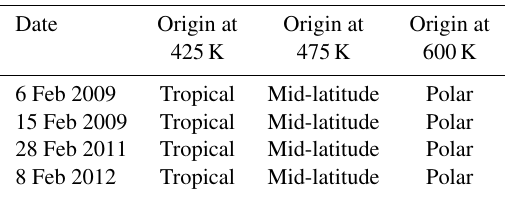
Table 6. Origin of ozone-poor air at isentropic levels for low-ozone events in